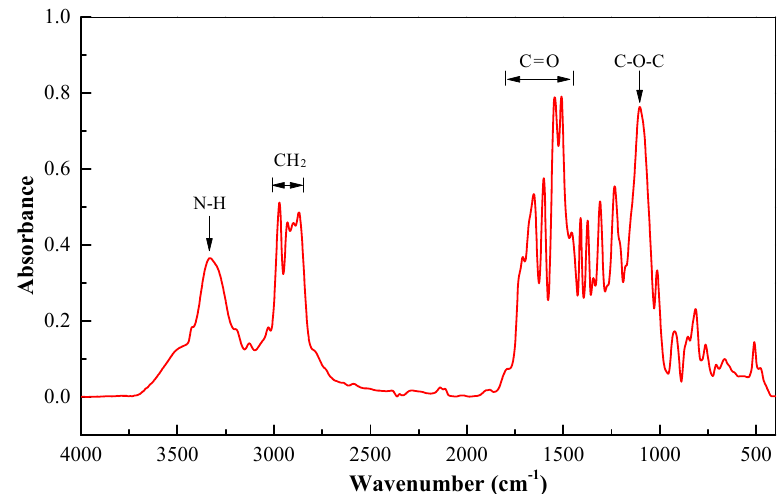
Figure 2. FT-IR spectroscopy of LINE-X 350 polyurea with typical peaks.